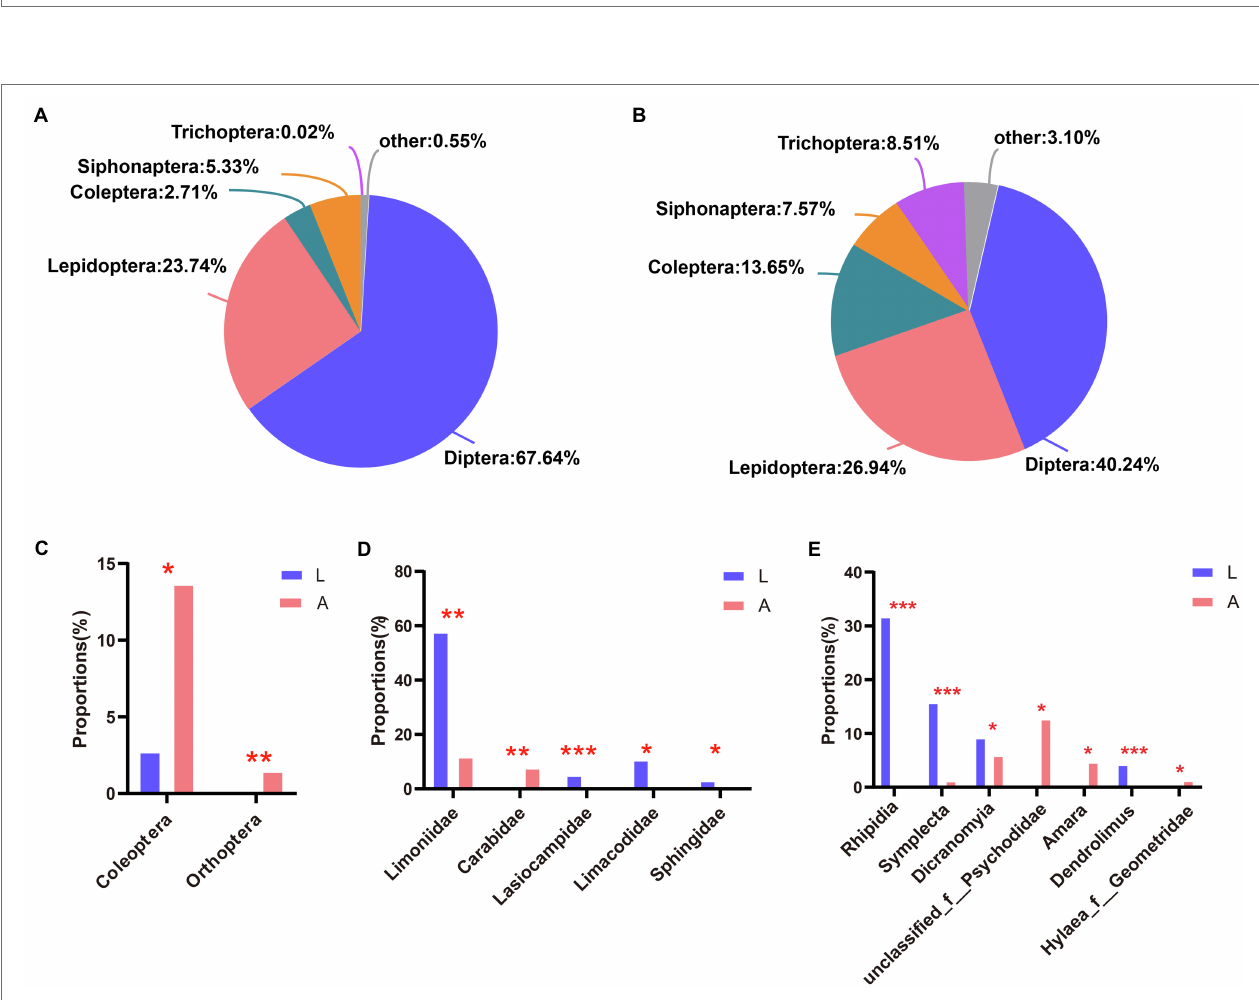
FIGURE 2 | Principal coordinate analysis (PCoA) analysis based on unweighted UniFrac metrics. (A) Differential insect composition in diet between lactating and non-lactating bats. (B) Differential gut microbiota communities between lactating and non-lactating bats.